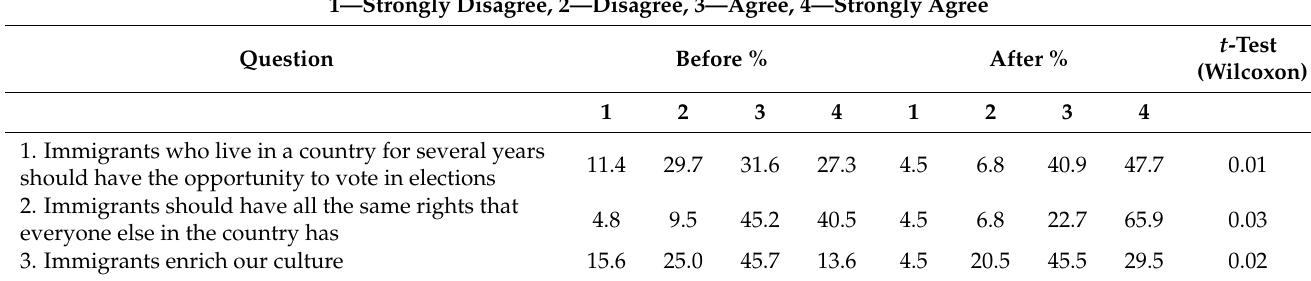
Table 8. What students stated in their journals at the end of the school year that they have learned to say and